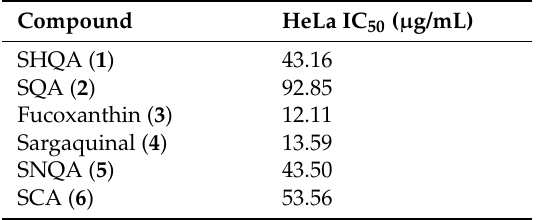
Table 3. Cytotoxicity assay results for compounds 1 – 6 against HeLa derivative